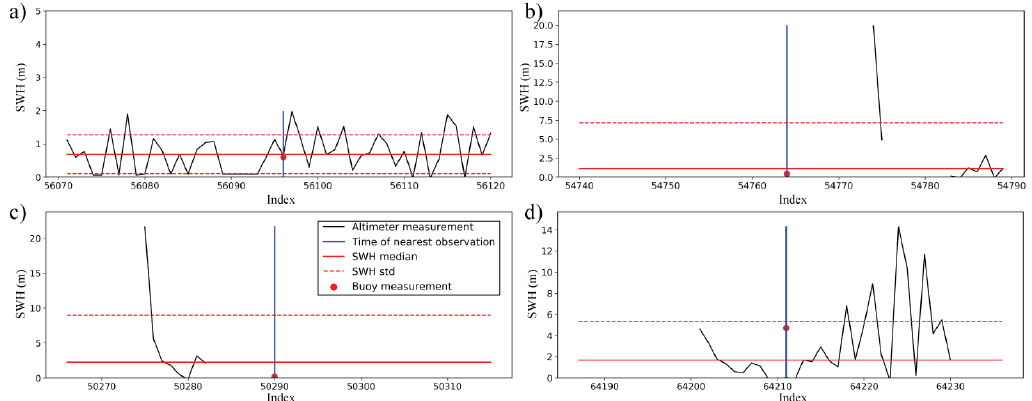
Figure 4. Examples of SWH profiles from MLE-4 for the nearest 51 points to each of four buoys; “index” refers to the records no. in data file. Points shown are those deemed “valid”, with red lines showing the median and ± 1 std. dev. of those estimates. The blue line marks the point of nearest approach to the buoy, with the red dot showing the buoy measurement. Locations are as in Figure 3a–d, namely ( a ) Buoy 62287 off Liverpool, UK. ( b ) Buoy 62304 in English Channel. ( c ) Buoy 44020 off Barnstable, MA, USA. ( d ) Buoy TFDRN in bay off NW